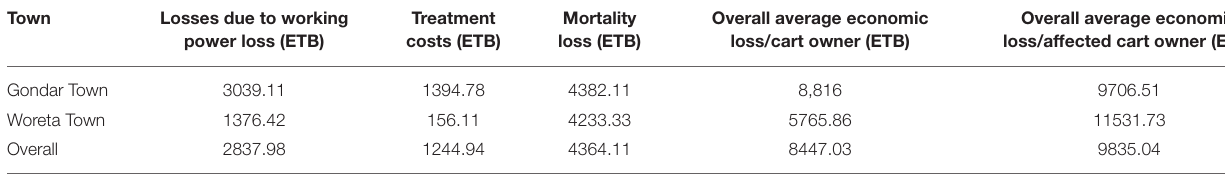
TABLE 4 | The overall average economic losses of epizootic lymphangitis per cart owner and per affected cart owner per year by town.